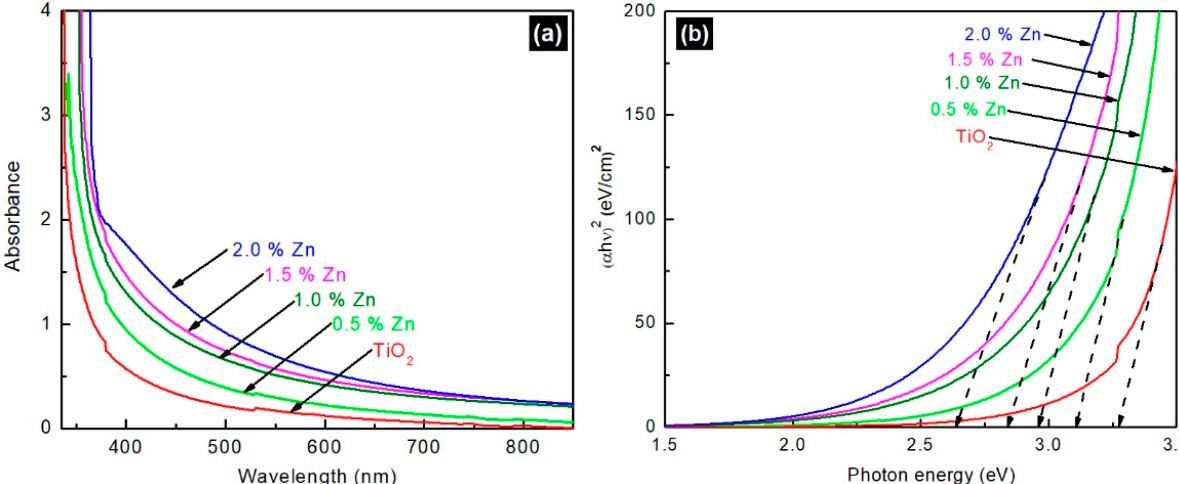
Figure 3. ( a ) UV-visible absorption spectra of undoped and Zn-doped TiO 2 nanomaterials; ( b ) Tauc-plot on estimated bandgap values of undoped and Zn-doped TiO 2 nanomaterials .